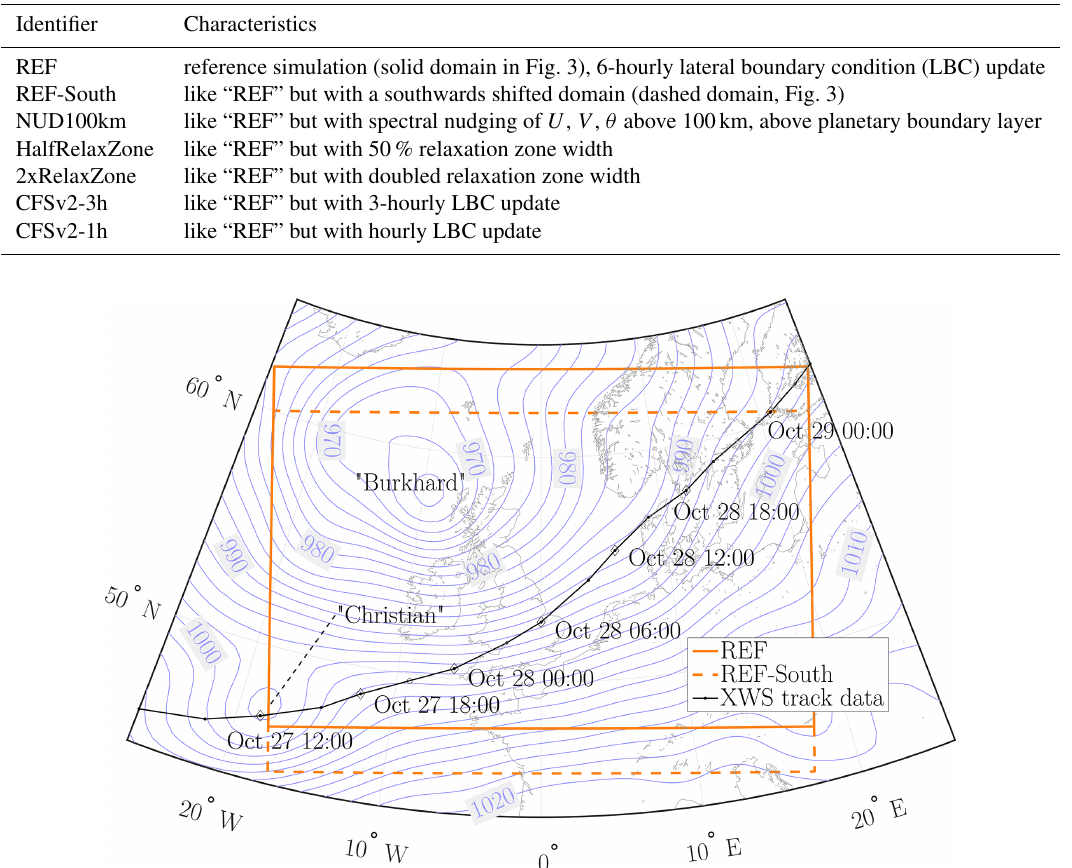
Table 2. Summary table of the seven WRF configurations with their identifier and a short description of their characteristics. Table adapted with modifications from Imberger et al. (2020), Table 2.